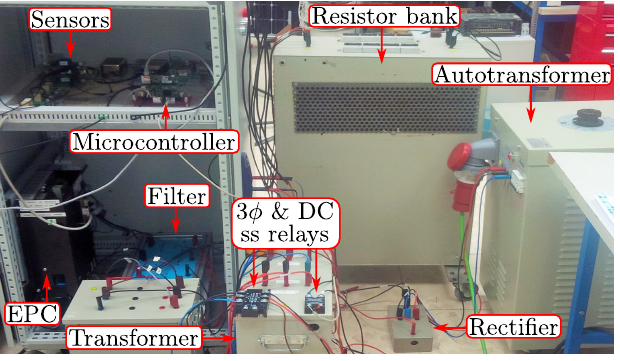
Figure 4. Experimental